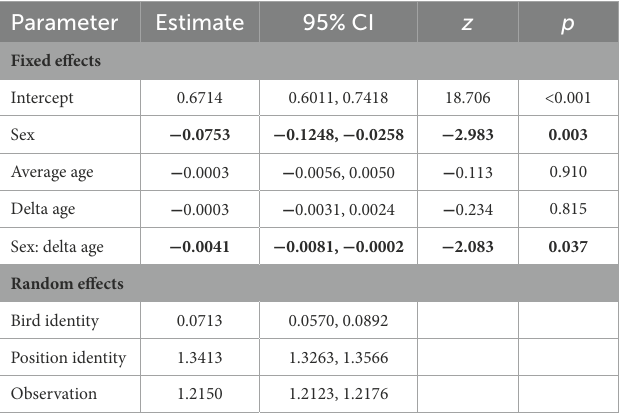
Table 1 Results from a generalised linear mixed model with a binomial error distribution testing whether variation in autosomal methylation level is explained by sex (males as a reference category) and the between- (average age) and within-individual (delta age) components of age.